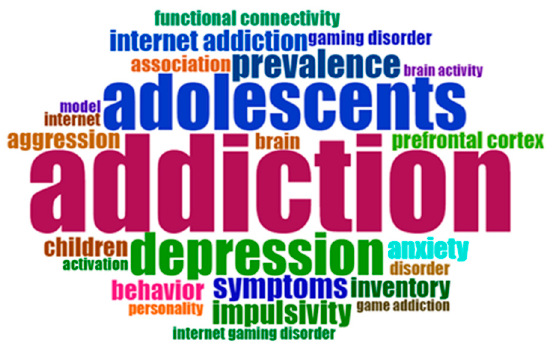
Figure 4. Word cloud of authors’ keywords.